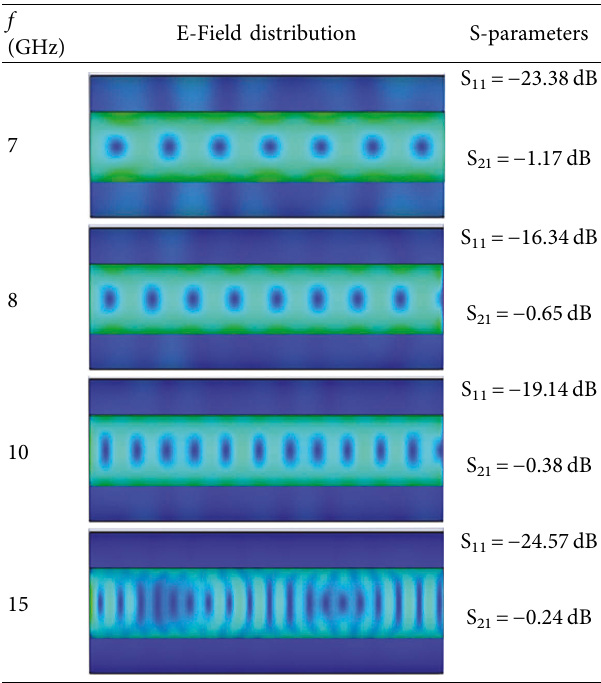
Table 3: The scattering parameters and the electric field distri- butions at the guided mode